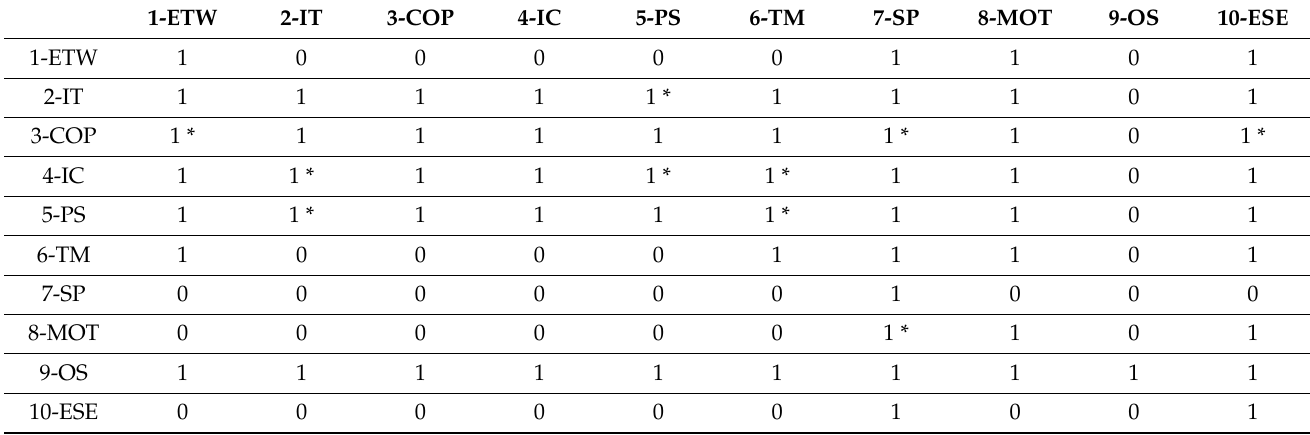
Table 3. The final reachability matrix of